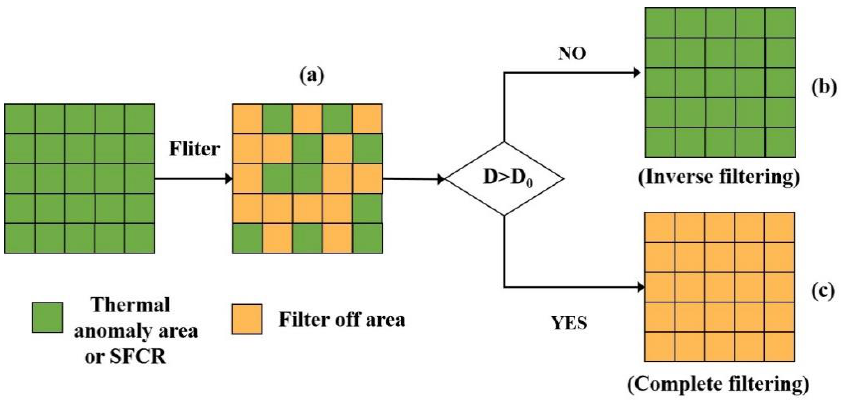
Figure 4. Schematic of filtering correction: ( a ) Preliminary filtering result; ( b ) Filtering correction result (do not meet threshold); ( c ) Filtering correction result (meet threshold).